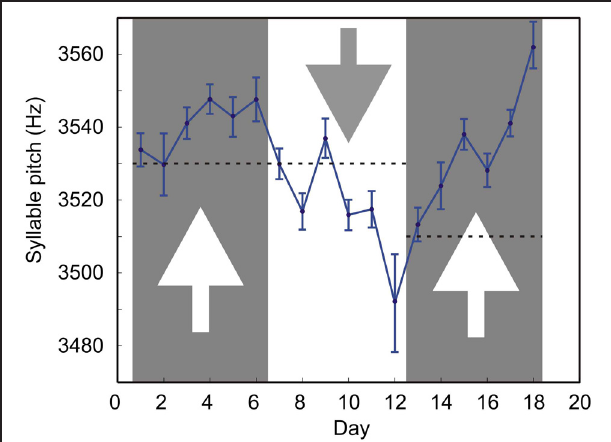
FIGURE 4 | Prolonged exposure of the bird to DAF causes gradual changes in the song. The mean pitch of one of the target song syllable was manipulated by feedback conditional on pitch. Each datapoint is the pitch of the target syllable averaged over all the renditions of the target syllable sung by the bird on a given day. The number of renditions varies from day to day (mean = 208, min = 126, max = 288). Error bars are s.e.m. Dashed lines are the values of the threshold. Arrows indicate the direction in which the syllable frequency was expected to change in response to DAF. Larger error bars on day 12 are mostly due to the smallest number of target syllable renditions ( n = 126) sung on that